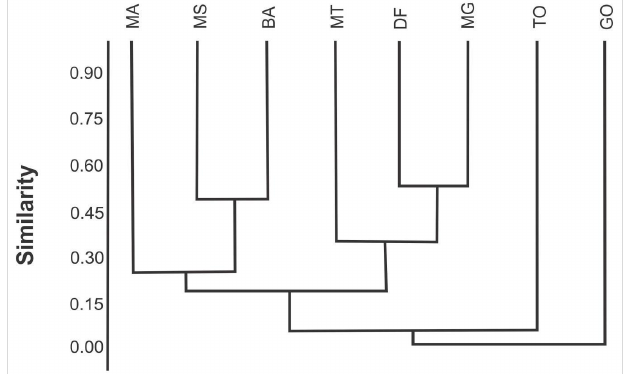
Fig 4 . Dendrogram drawn from the similarity Jaccard index among known areas, based on data from species of the Polybia genus.